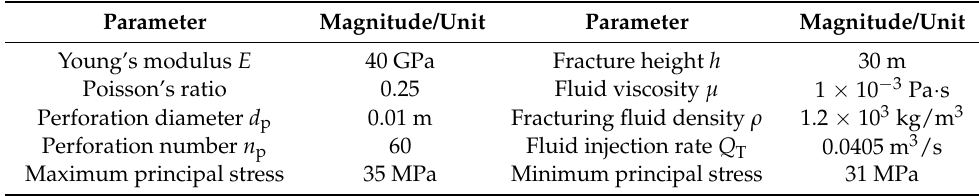
Table 1. Input parameters for numerical simulation.